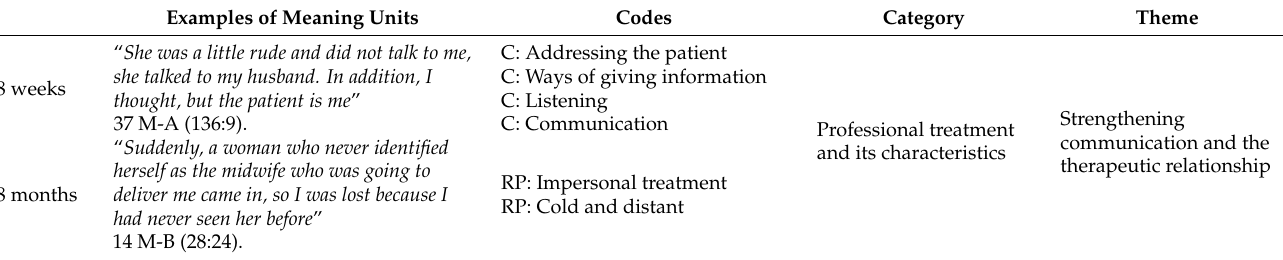
Table 3. Description of analysis